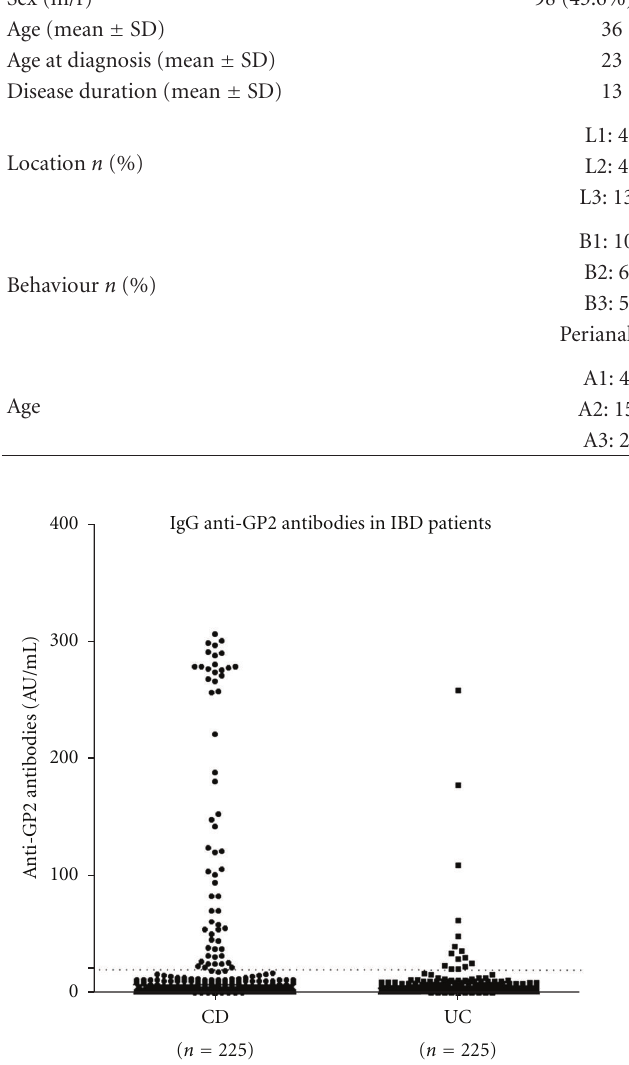
Figure 1: IgG anti-GP2 antibodies in 225 patients with Crohn’s disease (CD) and 225 patients with ulcerative colitis (UC). A cuto ff of 20AU/mL established by the manufacturer of the commercial ELISA (Generic Assays) is indicated with a dot